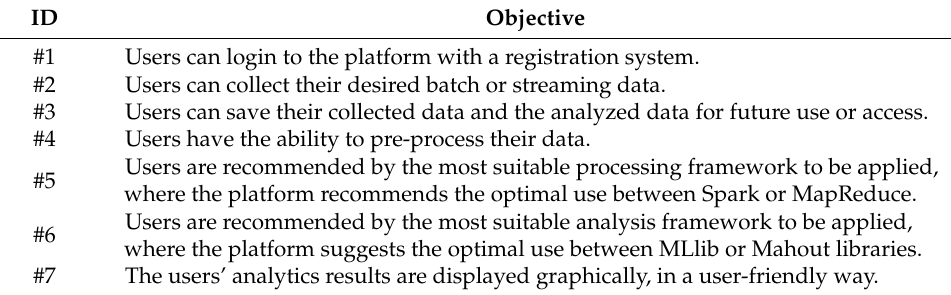
Table 1. EverAnalyzer objectives.